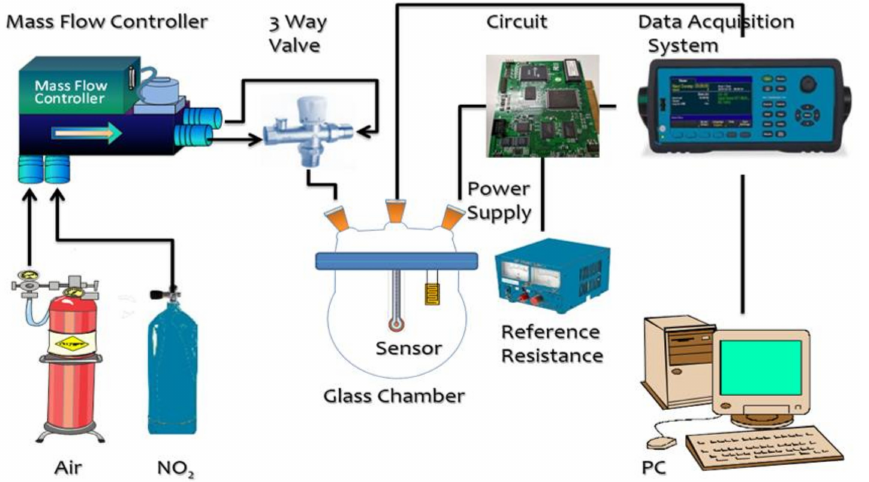
Figure 1. Diagrammatic representation of the experimental